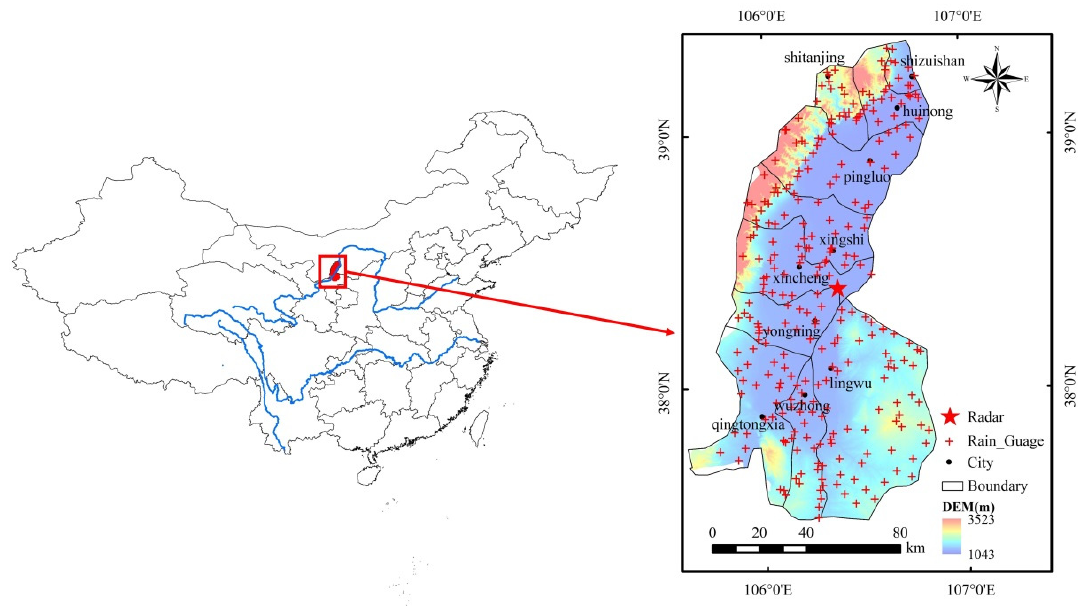
Figure 1. Spatial map showing the elevation of the study area, together with rain gauges and weather radar. weather